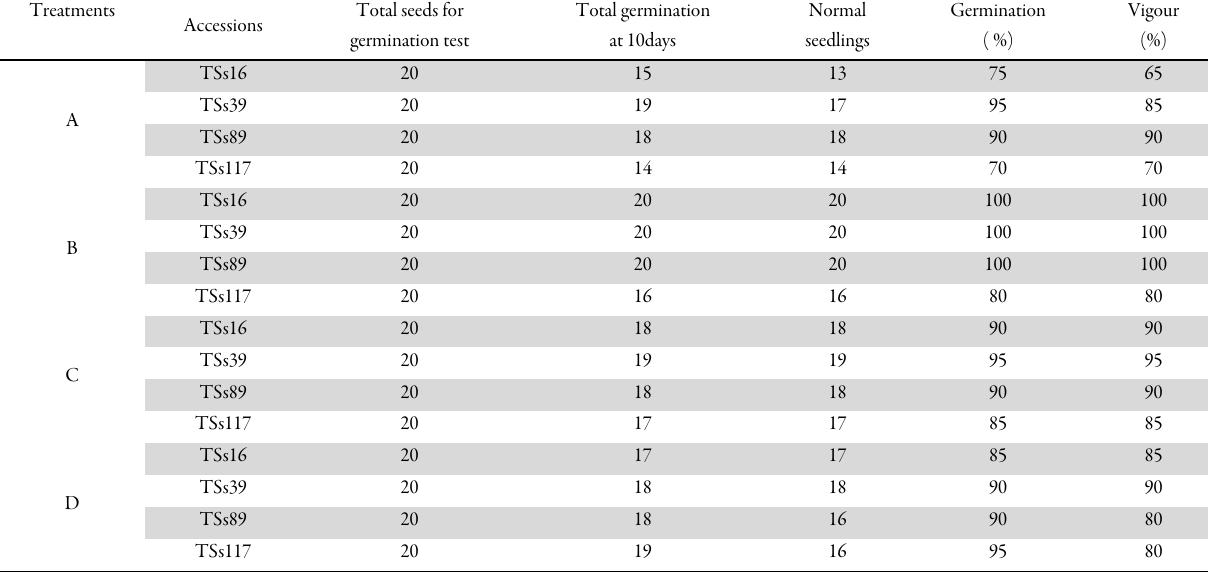
Table 5. The germination and vigour percentages of the seeds of the four accessions of African yam bean obtained from the various treatments Treatments